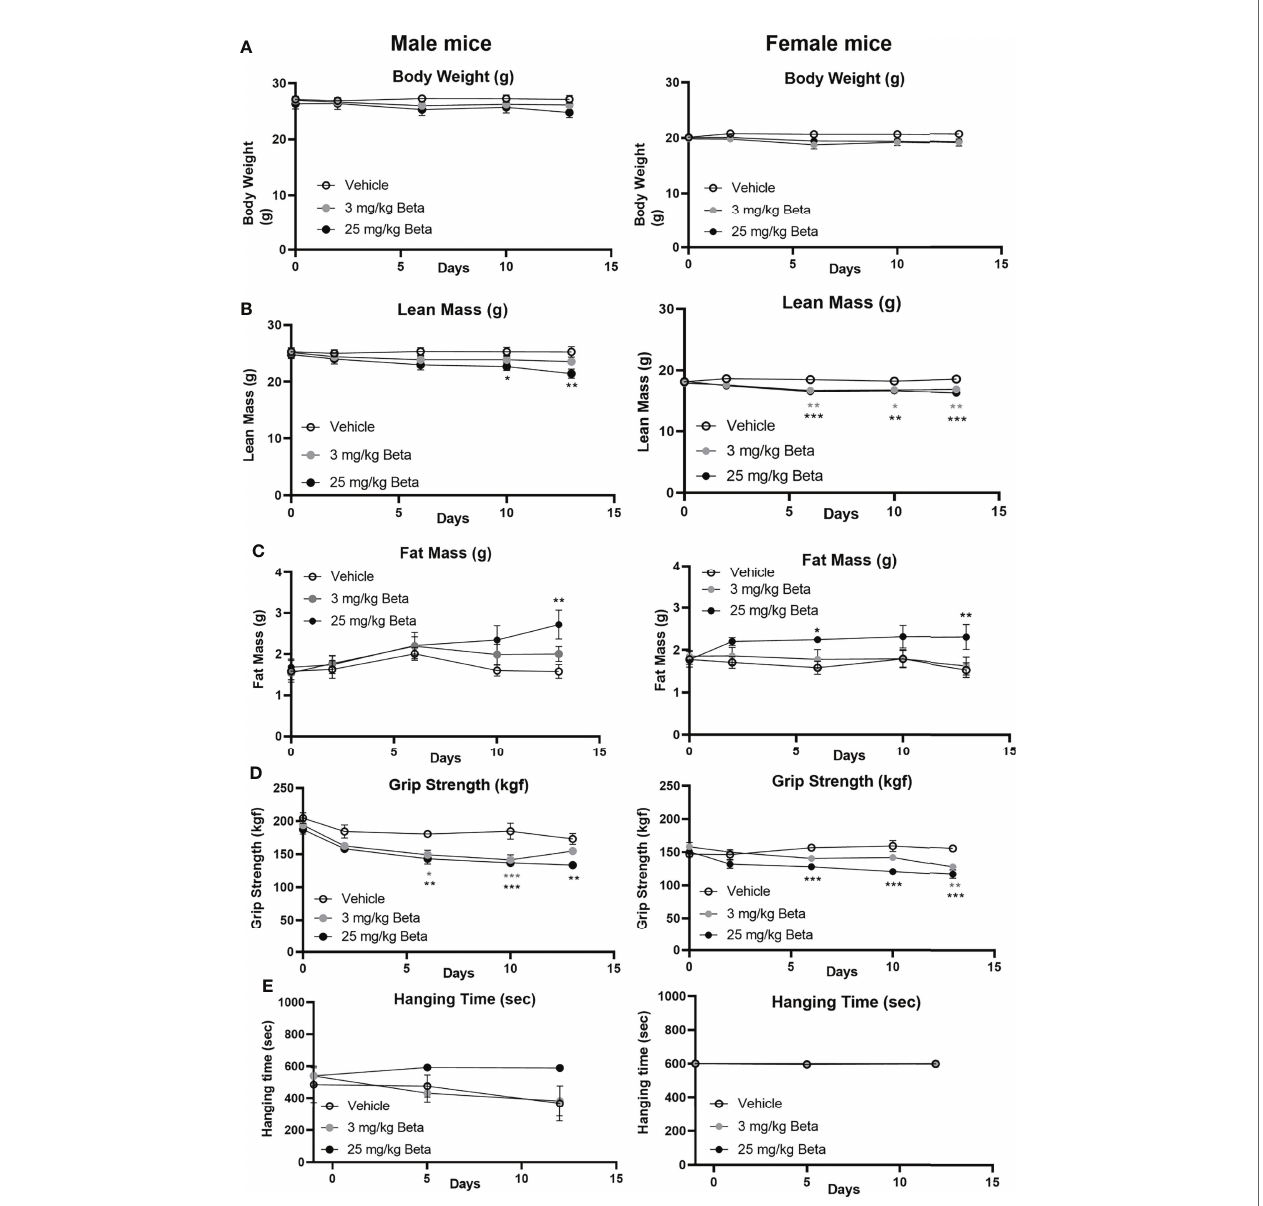
FIGURE 4 | Daily betamethasone treatment decreases muscle function in male and female mice. The effect of daily treatment with 3 or 25 mg/kg betamethasone on (A) total body mass, (B) lean mass, (C) fat mass, (D) fore limb grip strength, and (E) grid hanging time in male and female C57BL/6J mice. N=4 male mice/group, N=6 female mice/group. *p<0.05 vs. Vehicle, **p<0.01 vs. Vehicle, ***p<0.001 vs. Vehicle. Statistical signi fi cance was calculated using a one-way